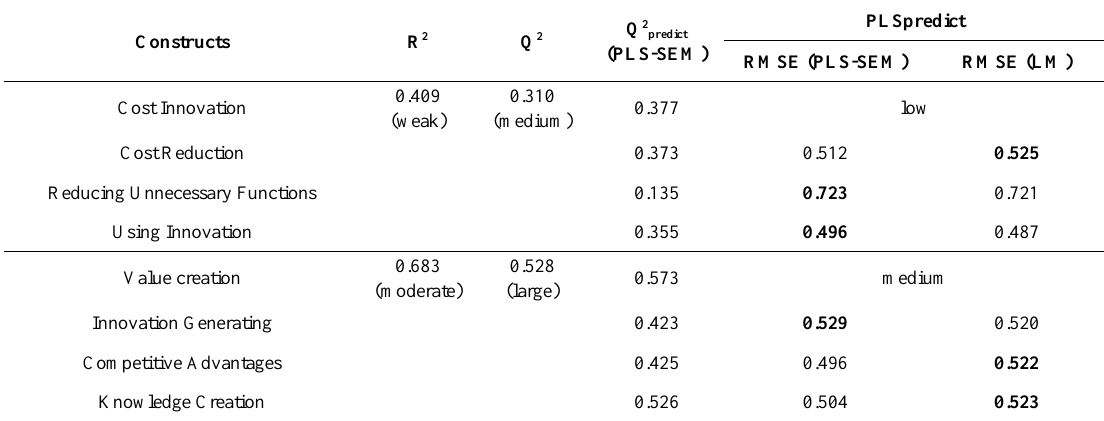
Table 5. Assessing structural